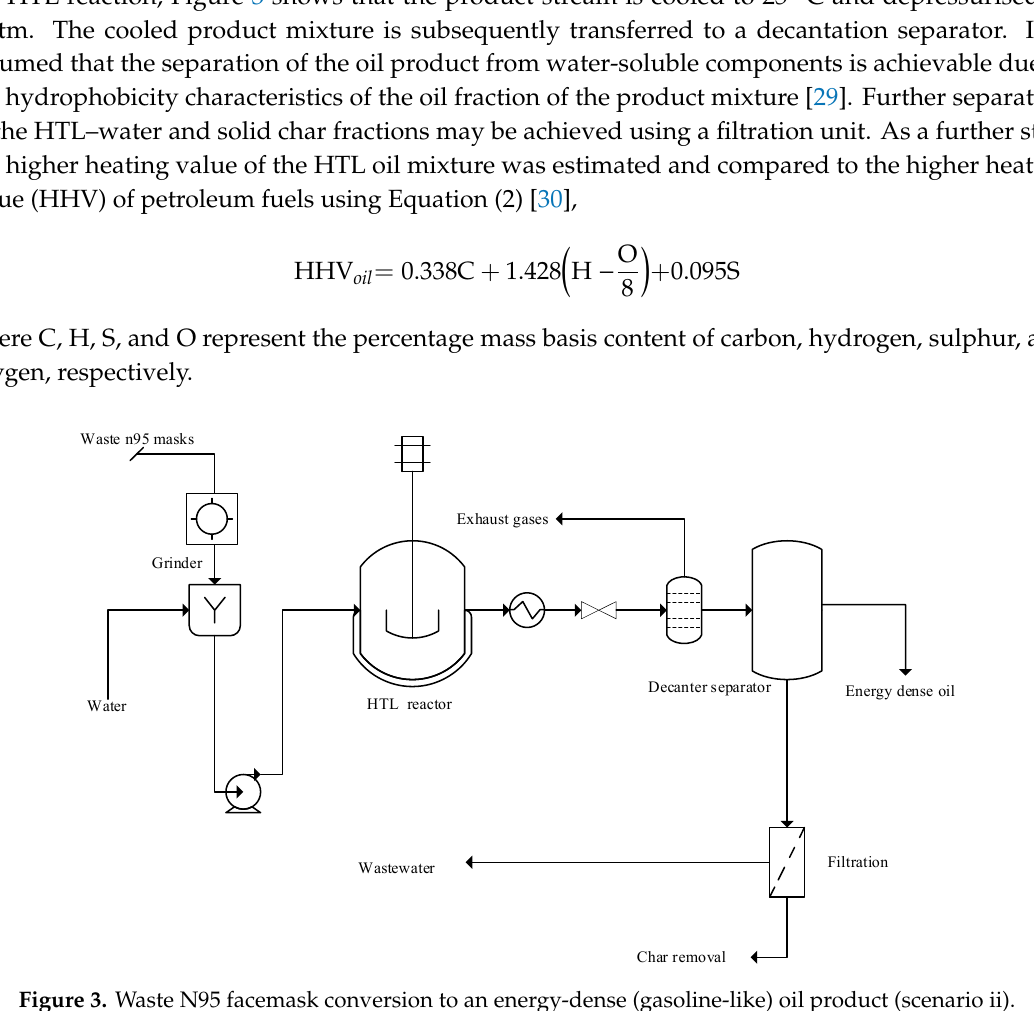
Figure 2. Waste N95 facemask conversion to the heat energy and electrical power (scenario i).